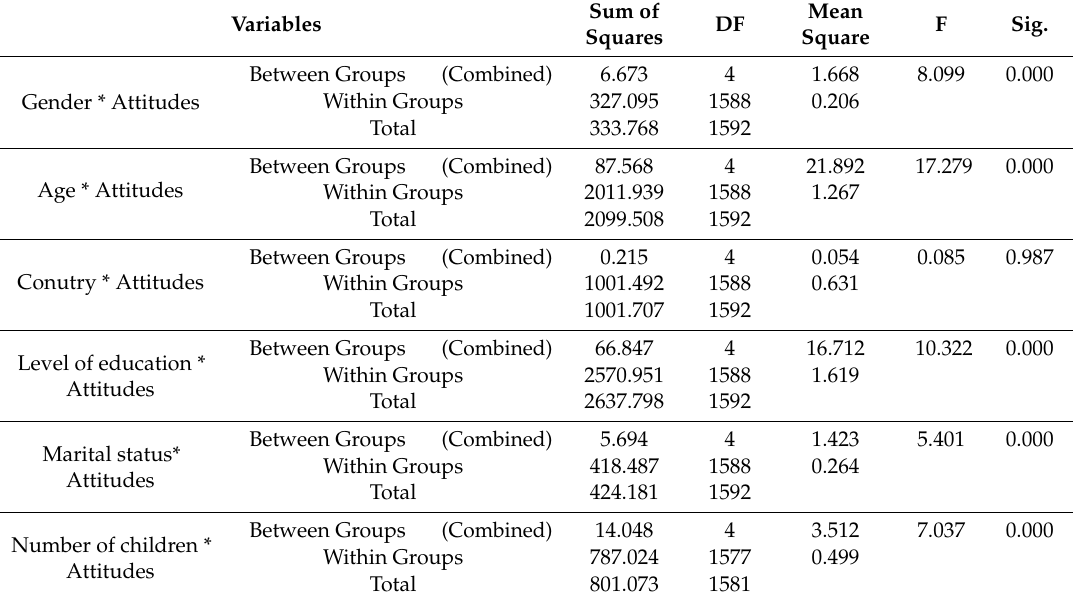
Table 3. ANOVA test of determination of di ff erences based on characteristics of